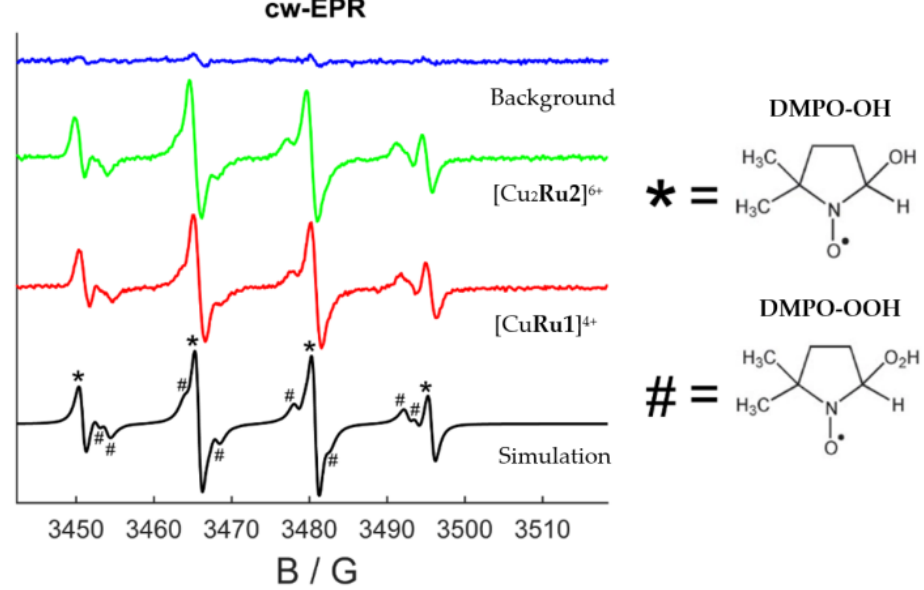
Figure 1. EPR spectra registered at 298 K of solutions containing DMPO and H 2 O 2 (blue line), together with [Cu Ru1 ] 4+ (red line) or [Cu 2 Ru2 ] 6+ (green line). The black trace is the best simulation (see text) obtained as a 50:50 mixture of hydroxide and peroxide radicals. Molecular structures of the corresponding adducts formed with DMPO are shown in the right part of the figure. The EPR lines referring to hydroxide and peroxide radicals are, respectively, labeled with symbols * and # . ([DMPO] = 750 mM, [H 2 O 2 ] = 100 mM, [[Cu Ru1 ] 4+ ] = [[Cu 2 Ru2 ] 6+ ] = 5